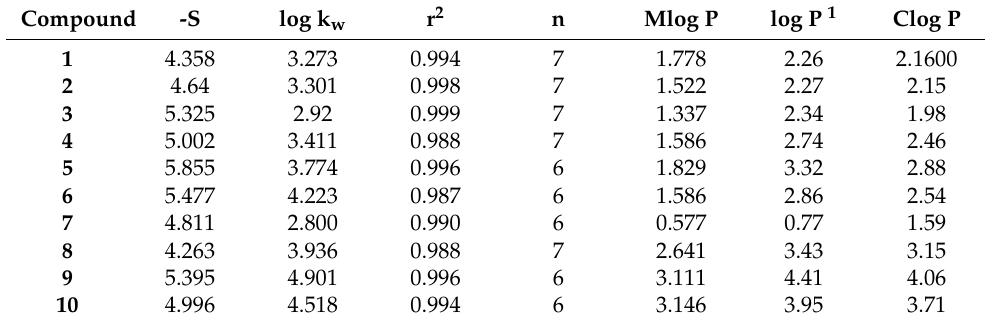
Table 4. Lipophilicity parameters of compounds: log k w(RP − 18) and -S values (Equation (1)) obtained by the RP-18 HPLC chromatography (pH = 7.4) and computational methods.